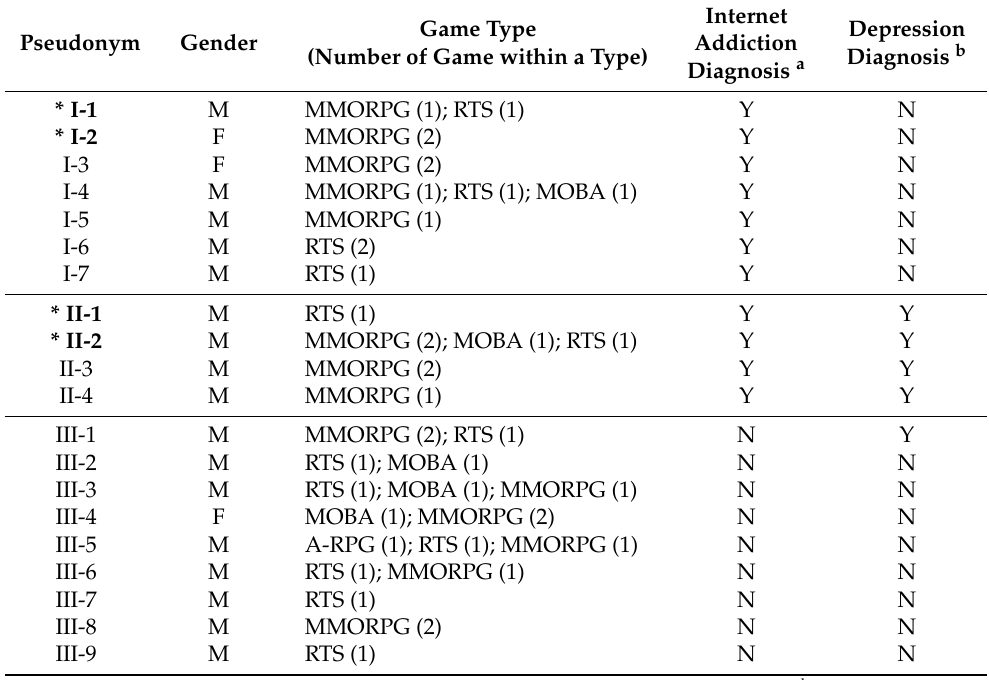
Table 2. Description of characteristics of the